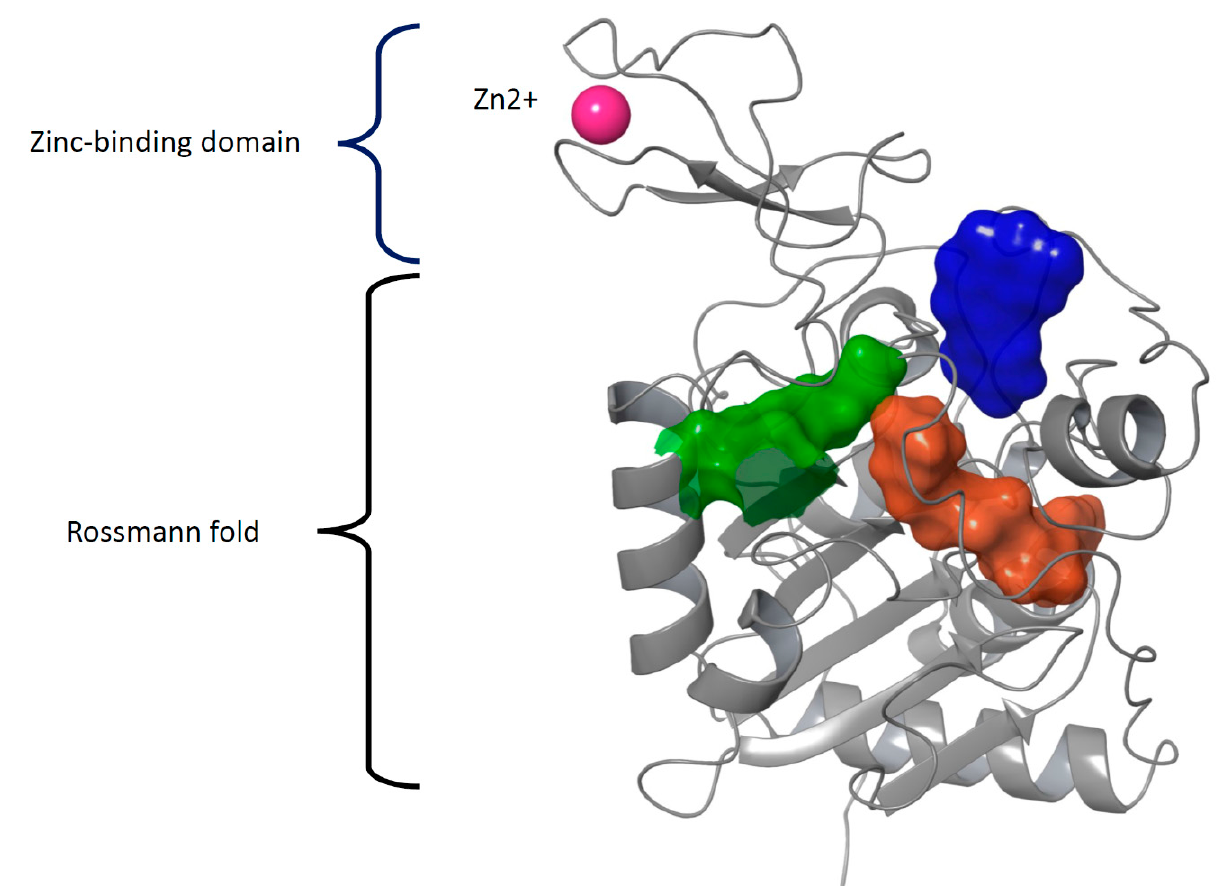
Figure 3. The structural domains forming the catalytic core of all sirtuins. The large, nucleotide-binding Rossmann fold domain comprises a six-stranded beta-sheet sandwiched between several alpha-helices, whereas the smaller zinc-binding domain is formed by four cysteine residues coordinating the Zn 2+ cation (PDB IDs 3GLT and 6QCD). The binding pockets of the substrate (green), co-factor (pockets A and B, both in brown), and inhibitor (pocket C, blue) in SIRT3 are surrounded by flexible loops.